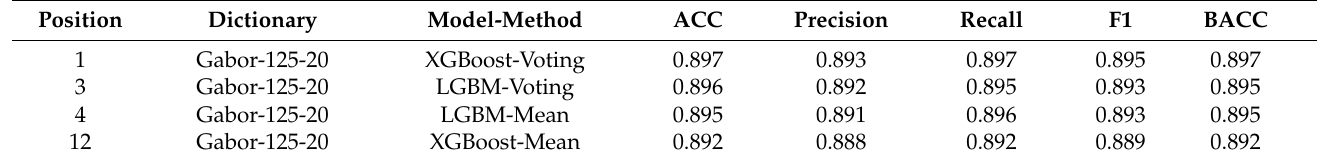
Table 3. Summary of average metrics scores for each data model, class size = 2.